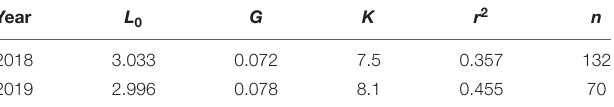
TABLE 5 | Parameters of the L t = L 0 . e G . t growth equation of Scomber japonicus larvae in the northern Satsunan area in 2018 and 2019.